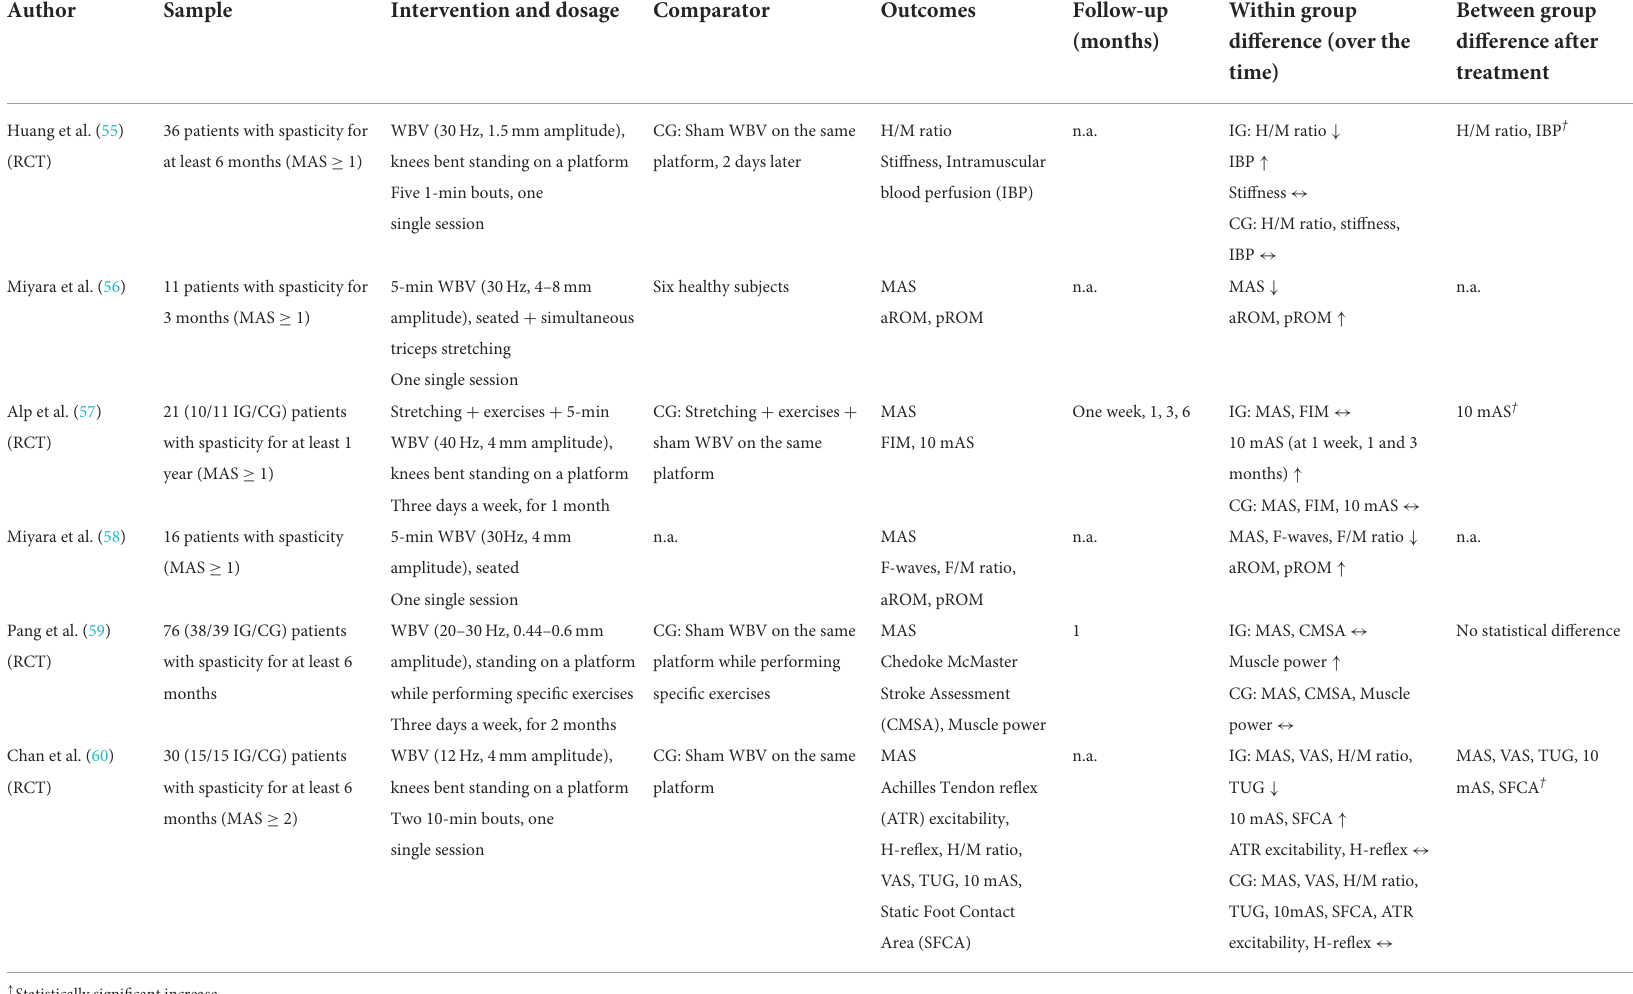
TABLE 6 Characteristics of studies using vibrations for the treatment of triceps spasticity after